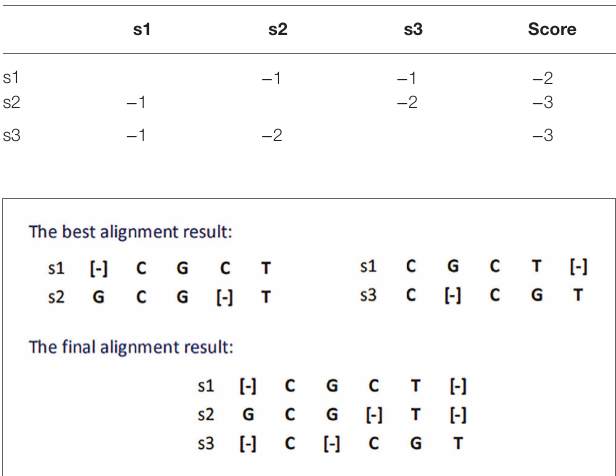
FIGURE 1 | Result of star sequence